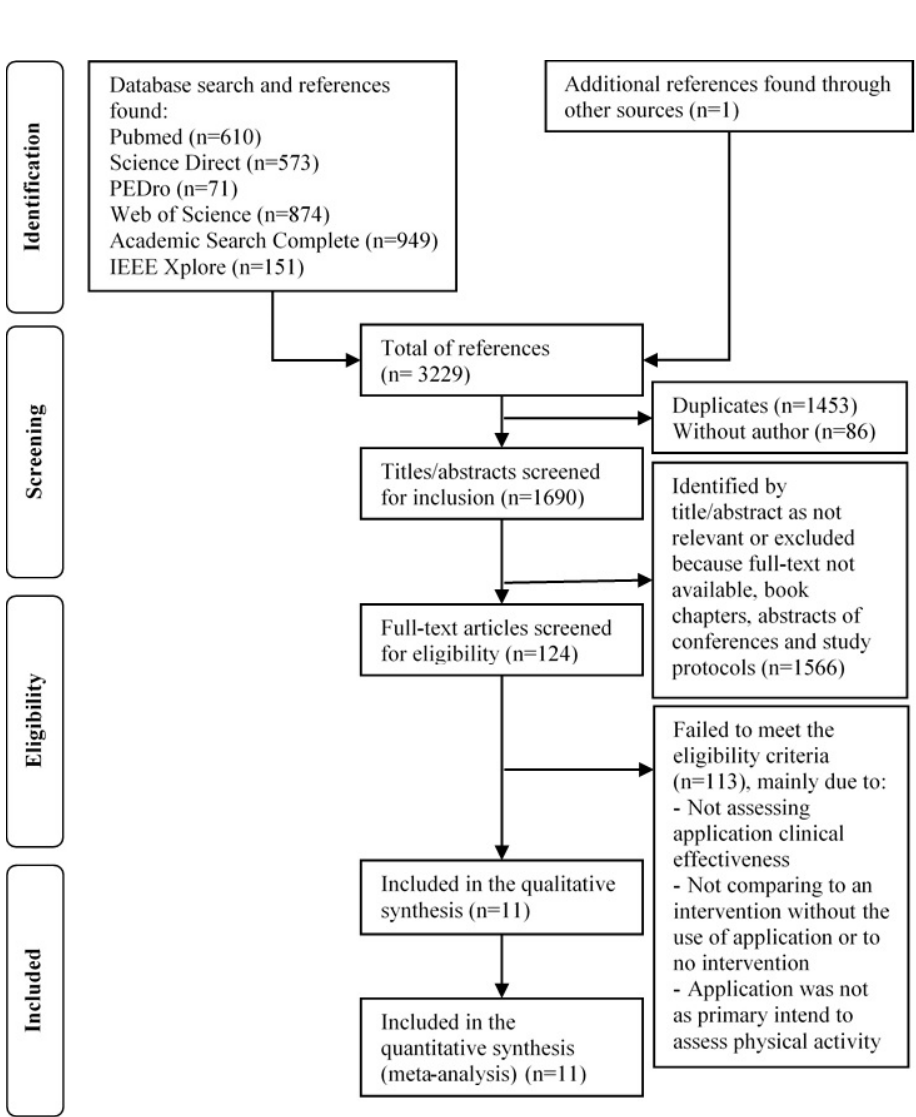
Figure 1. Preferred Reporting Items for Systematic Reviews and Meta-analysis (PRISMA) flow diagram. Abbreviations: PEDro, Physiotherapy Evidence Database.